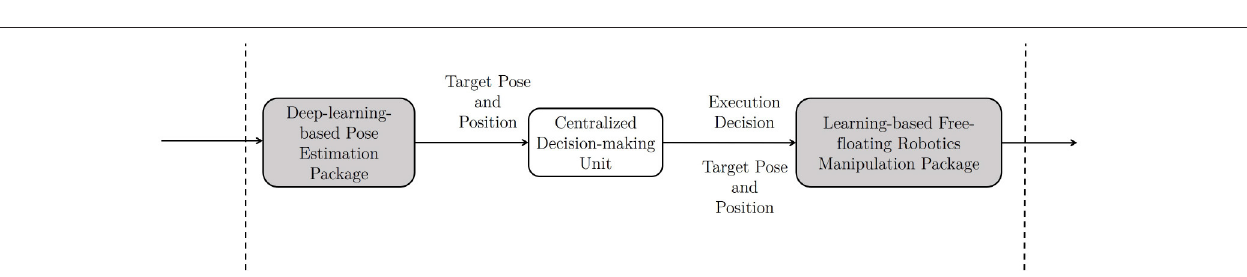
FIGURE 10 | The two aforementioned Artificial Intelligence (AI) packages are connected through a decision-making block, which can use a conventional method as an intermediate